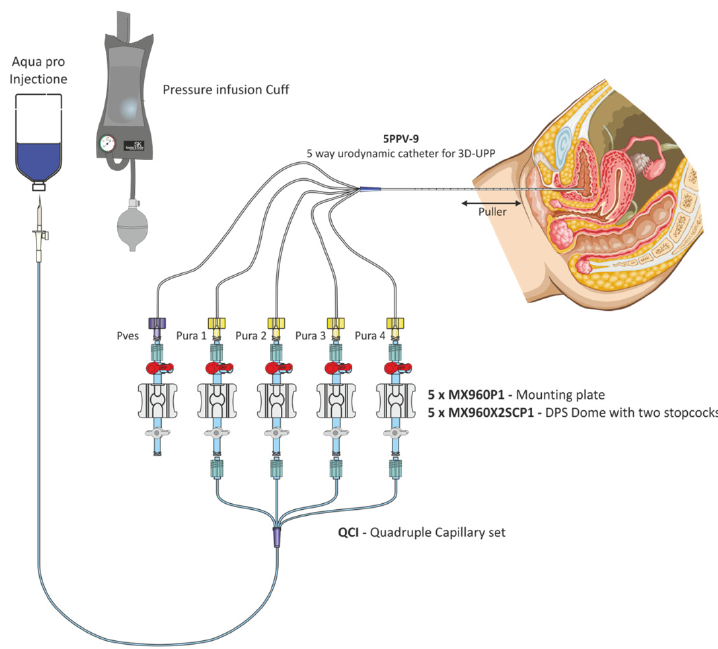
Figure 2. Connection diagram.